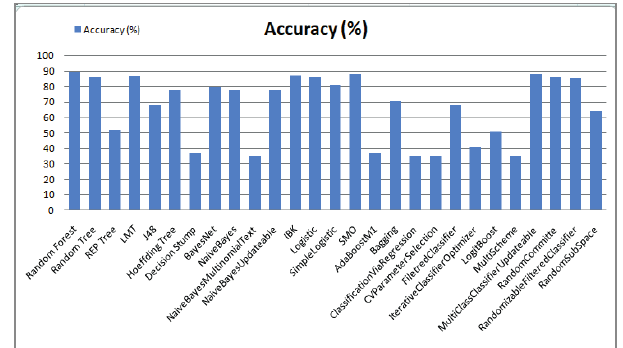
Fig. 3. Accuracy obtained for each classifier for Roman Urdu